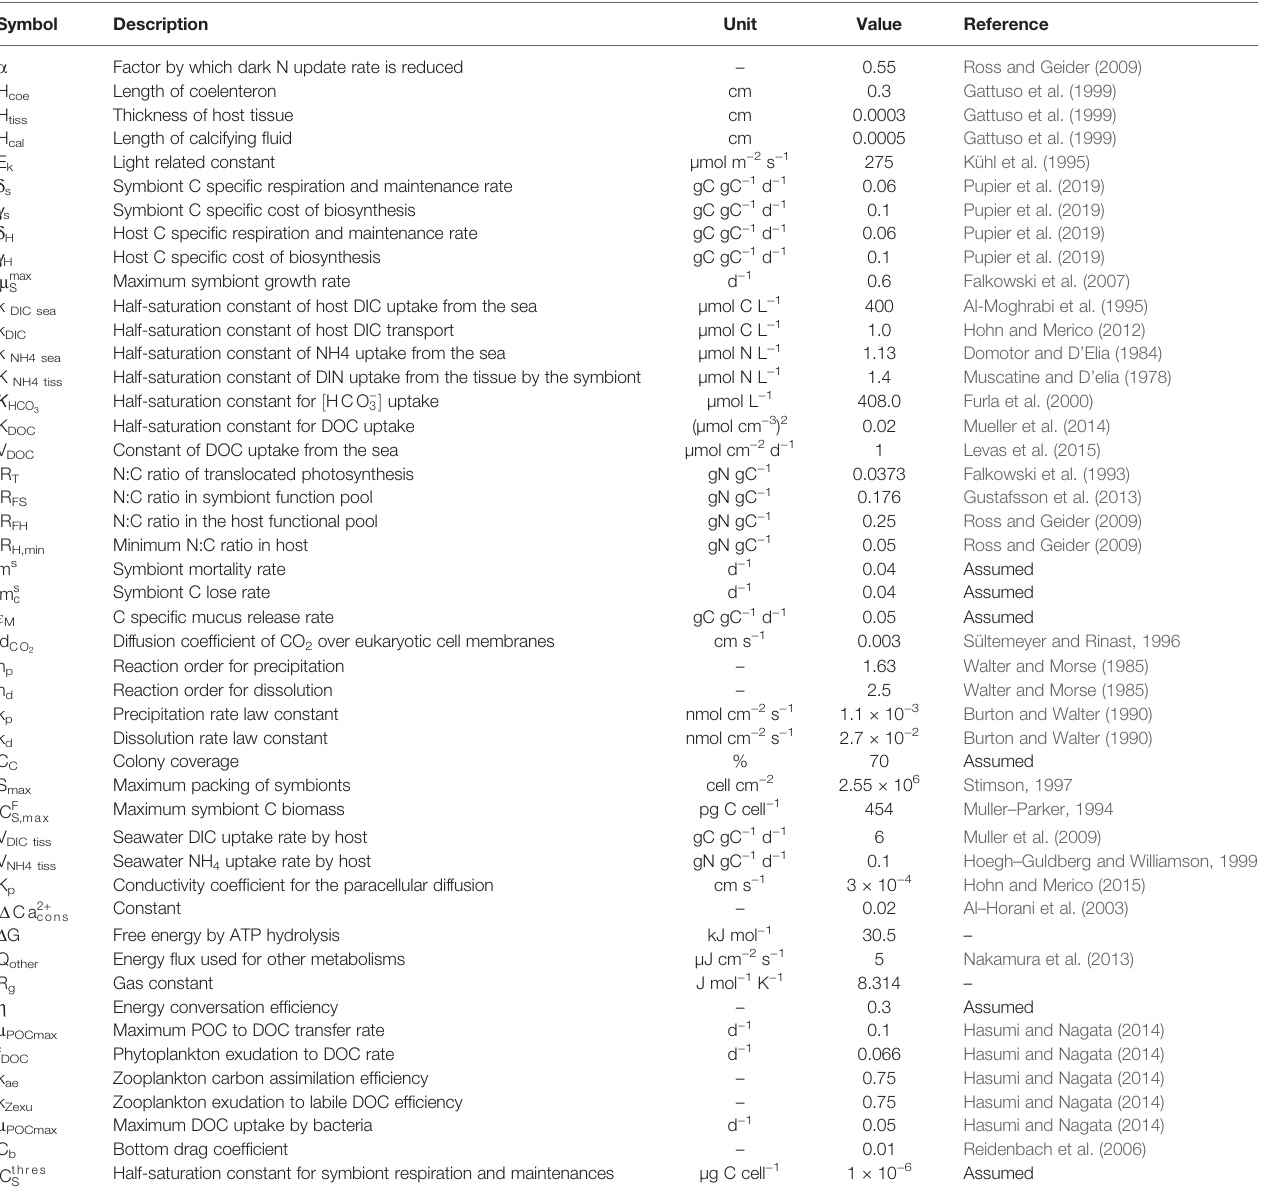
TABLE 2 | Model parameter